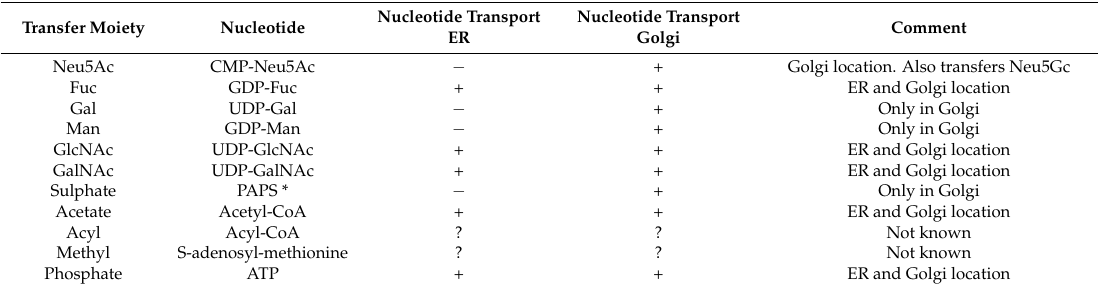
Table 6. Nucleotide Forms for Transfer to Mucins.